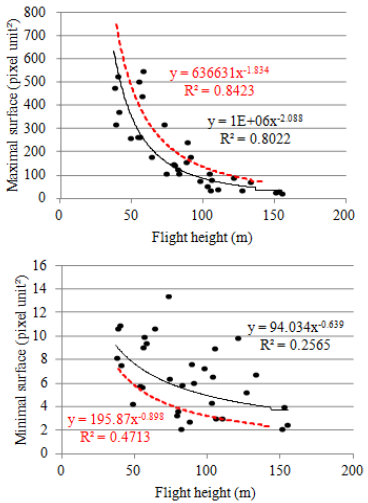
Figure 5: Polynomial regressions for the determination of maximal and minimal surfaces used in polygons selection. The red curves represent the final equations used as input parameters in the algorithm.